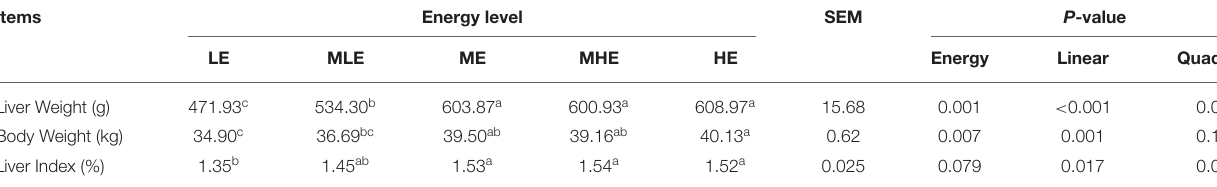
Values with different letters were significantly different (p < 0.05).